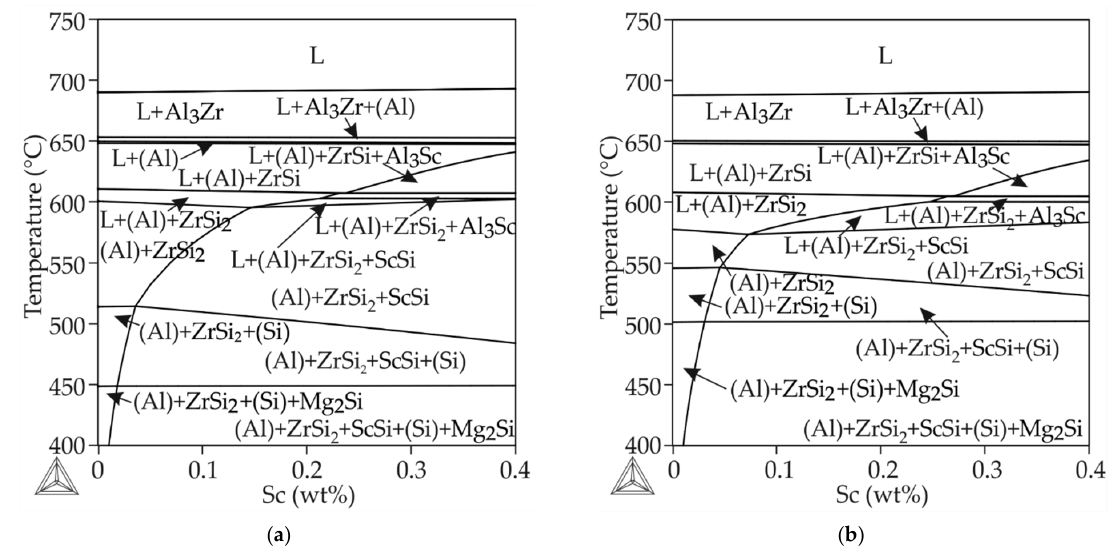
Figure 5. Polythermal sections ( a ) Al-0.3%Mg-1%Si-0.15%Zr-(0–0.4)% Sc (wt. %) and ( b ) Al-0.5%Mg-1.3%Si-0.15%Zr-(0– 0.4)%Sc (wt. %) of the Al–Mg–Si–Zr–Sc phase diagram calculated using Thermo-Calc software.